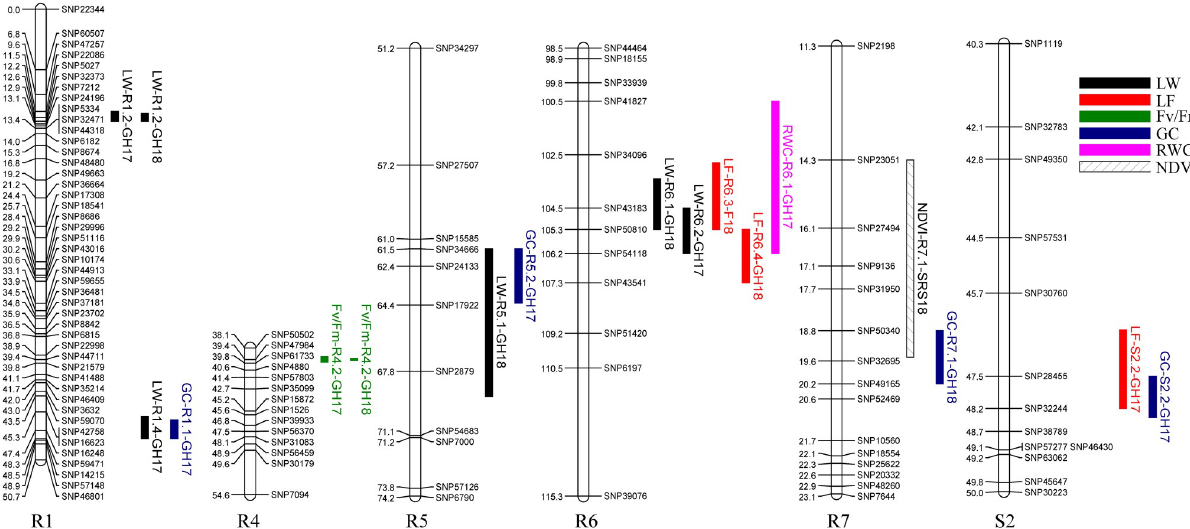
Fig 3. Co-localization of quantitative trait loci (QTL) on linkage groups R1, R4, R5, R6, R7, S2 for drought related traits in St. Augustinegrass Raleigh x Seville F 1 population evaluated under greenhouse (GH17 and GH18) and field conditions (SRS18). CHC, chlorophyll content; GC, green cover percent; RWC, leaf relative water content; LW, leaf wilting; LF, leaf firing; NDVI, normalized difference vegetation index.